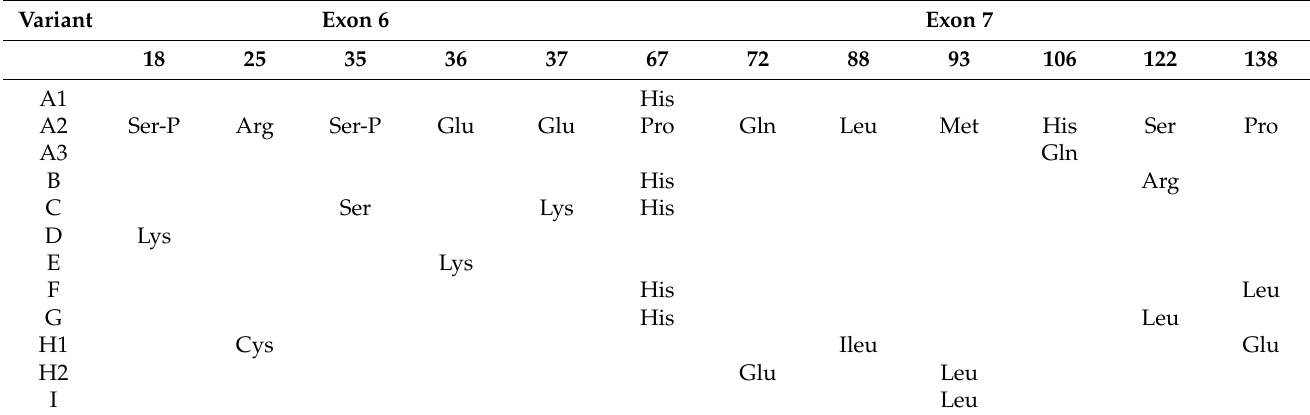
Table 1. Changes in the amino acid sequence in the bovine β -casein